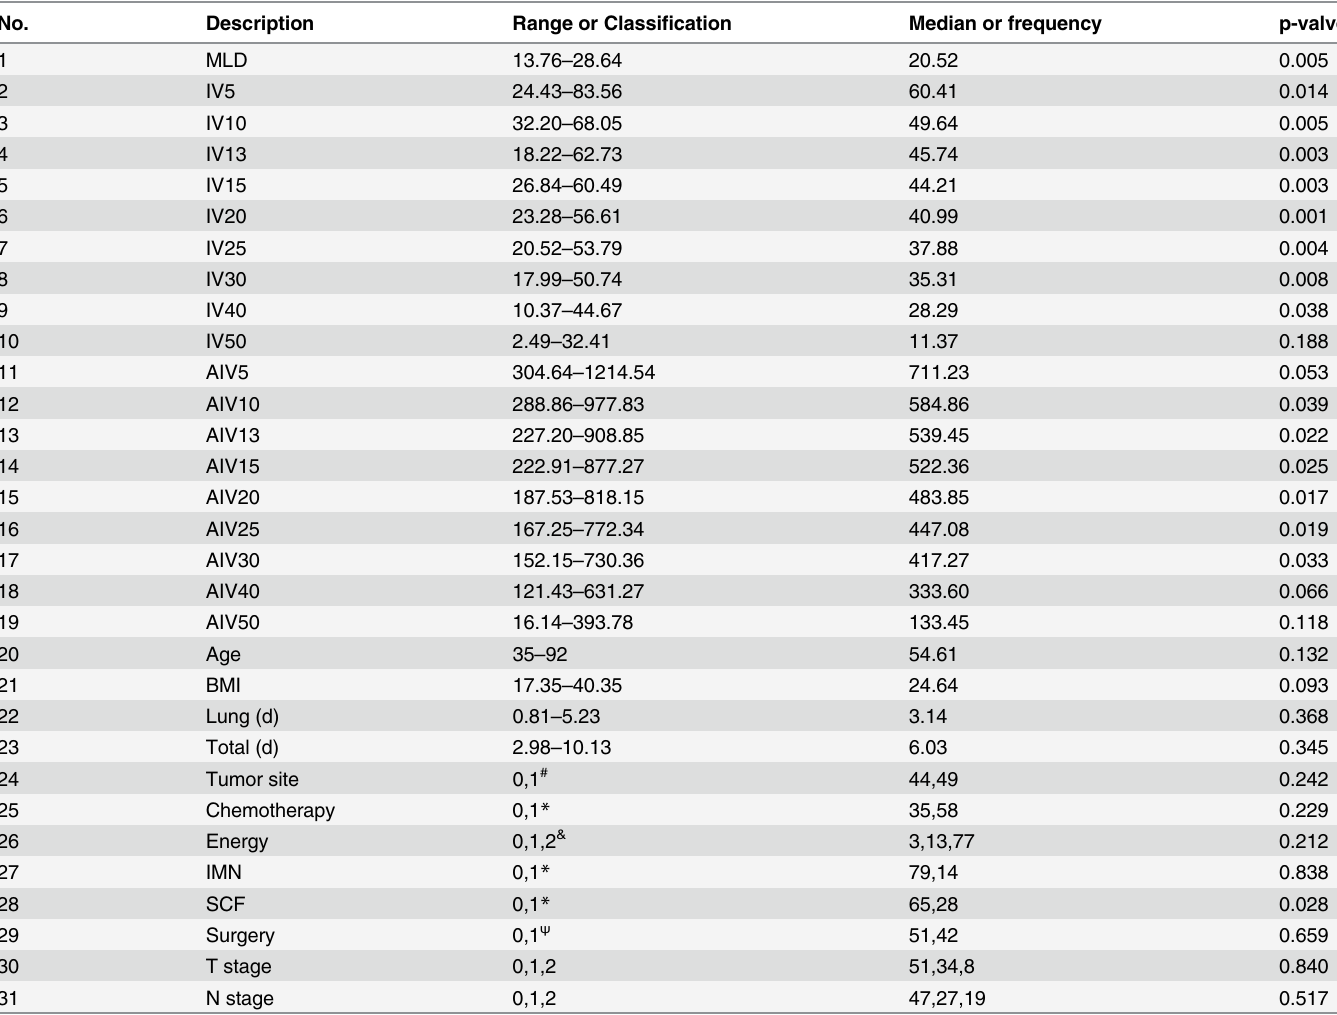
Table 2. Candidate predictive factors